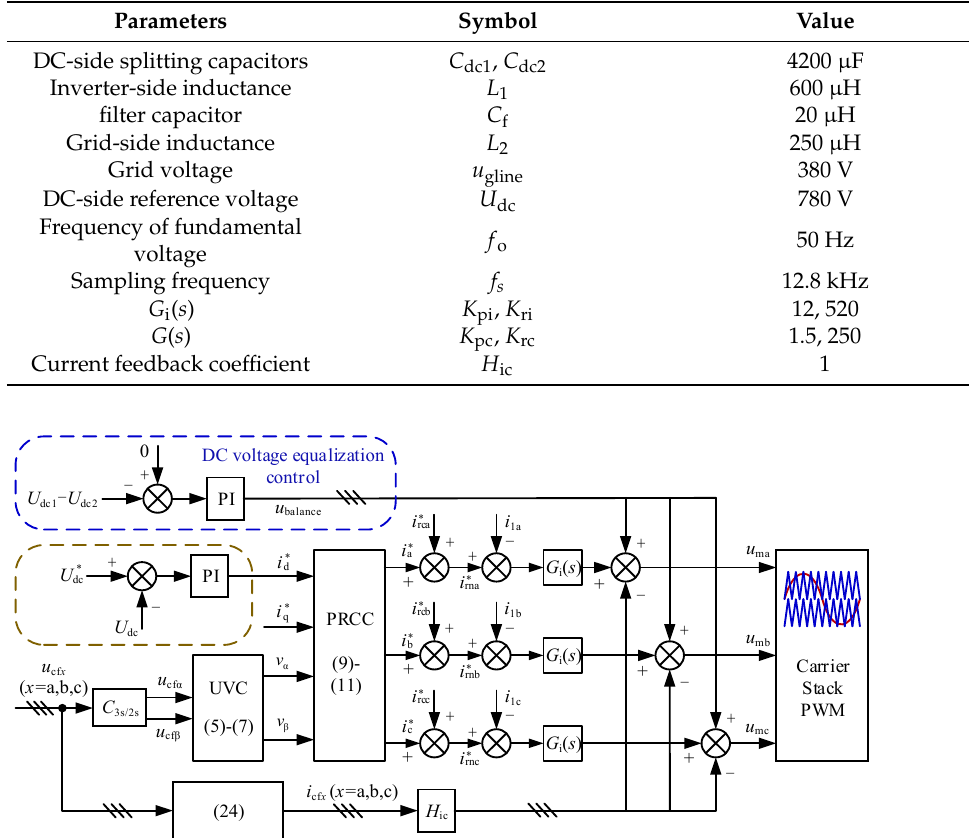
Table 1. Parameters used for simulation.